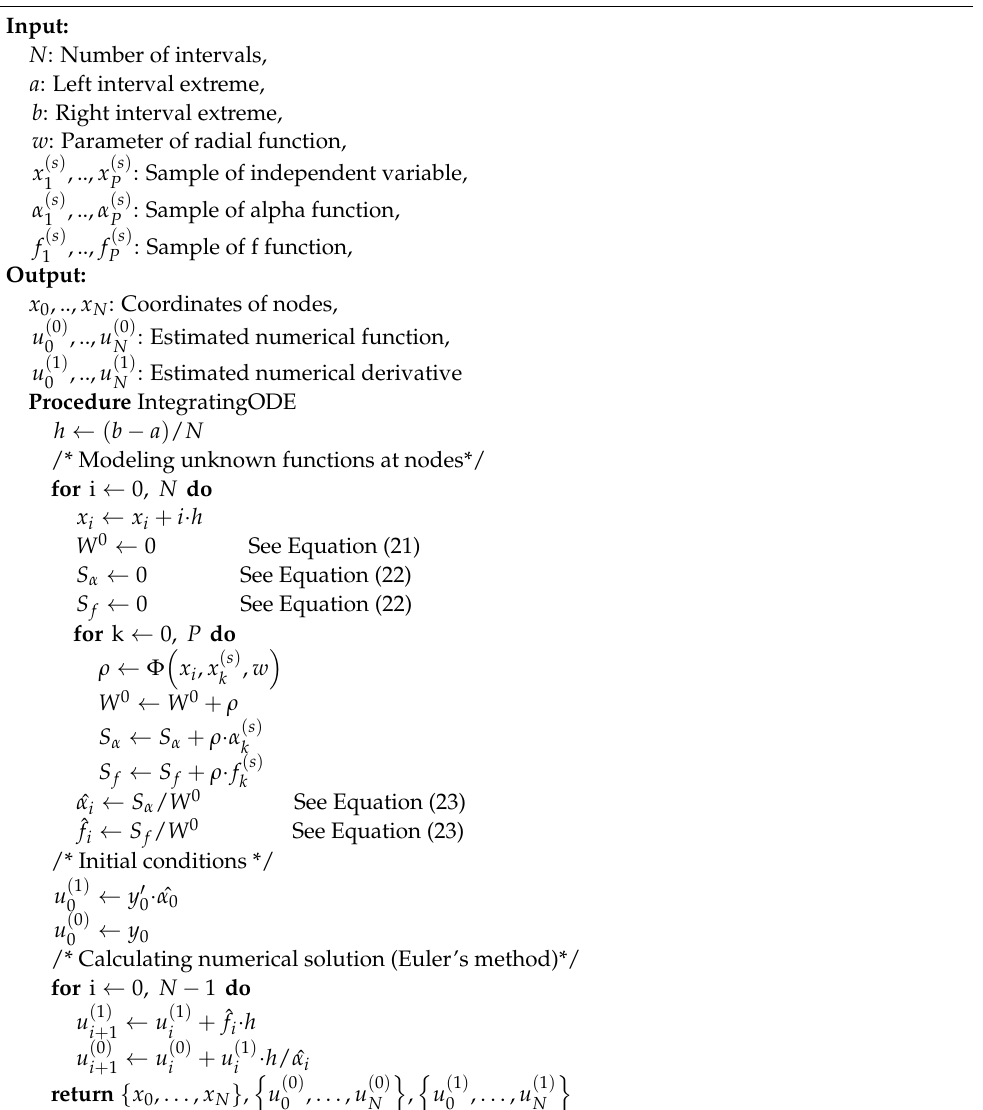
Algorithm 1. Sampled factors ODE numerical